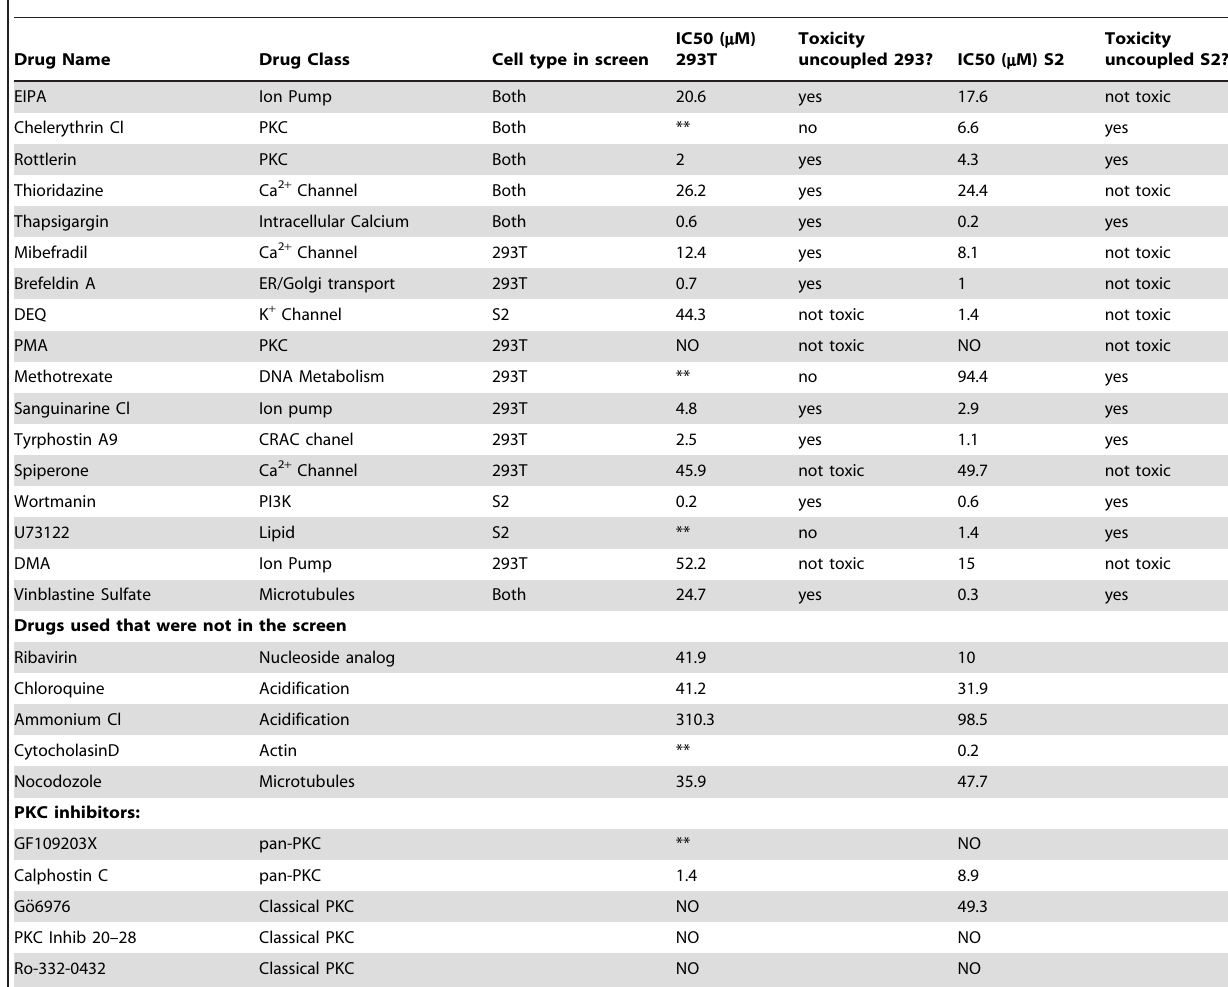
Table 1. Inhibitors of RVFV